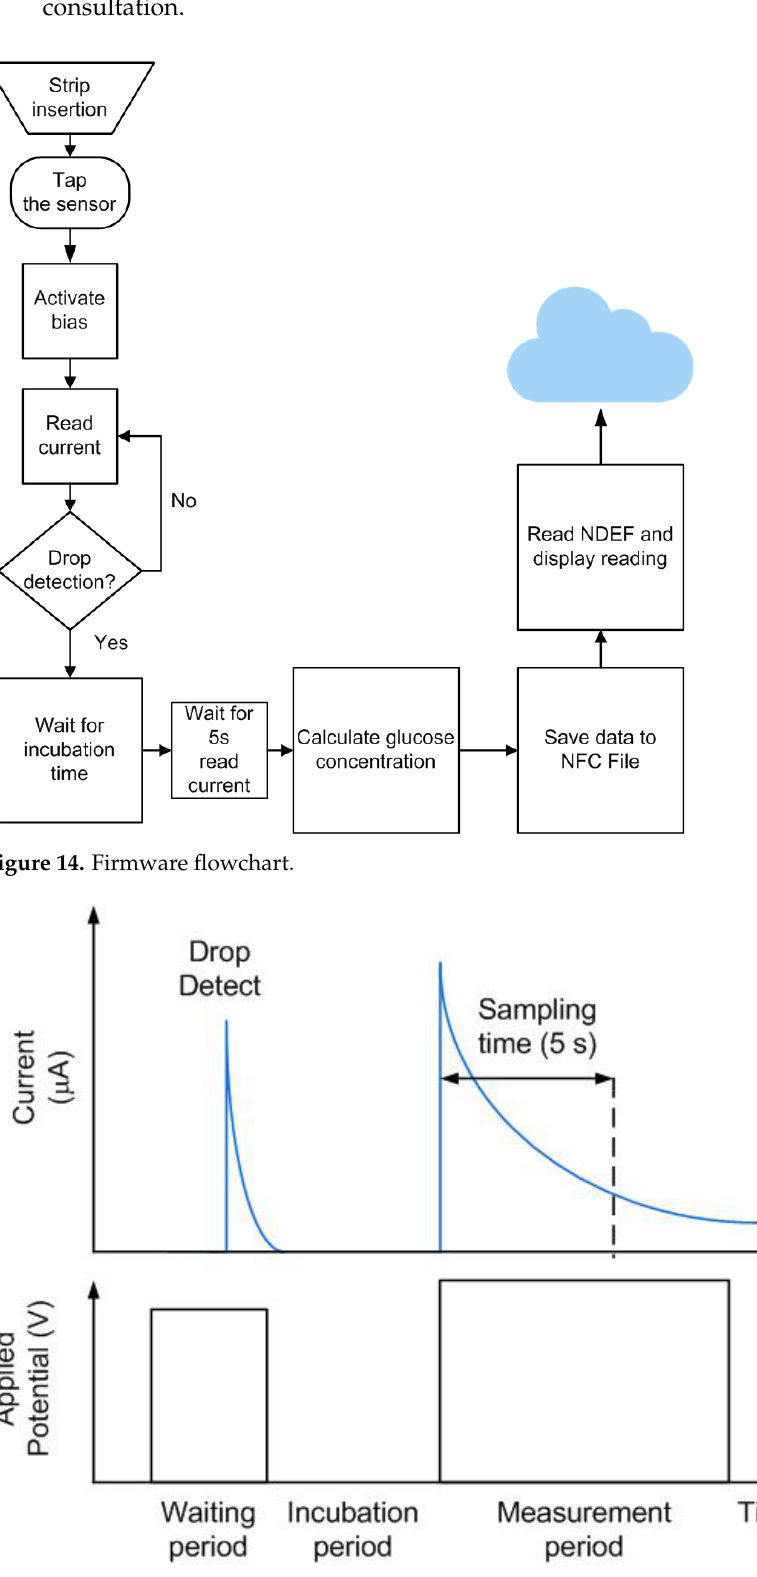
Figure 15. Test strip timing